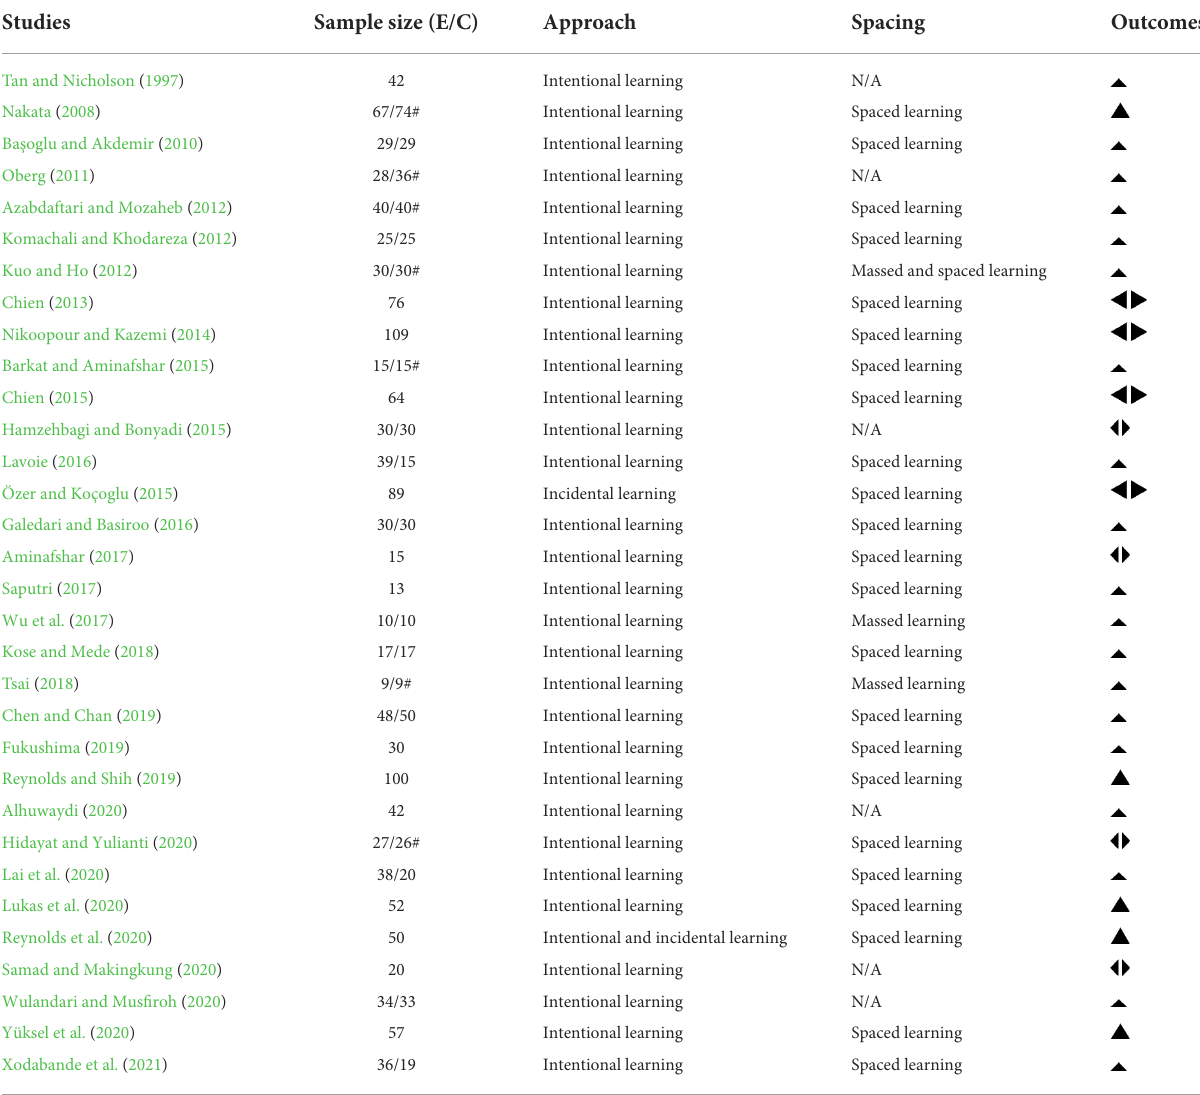
TABLE 6 Effect direction plot for learning conditions ( k =